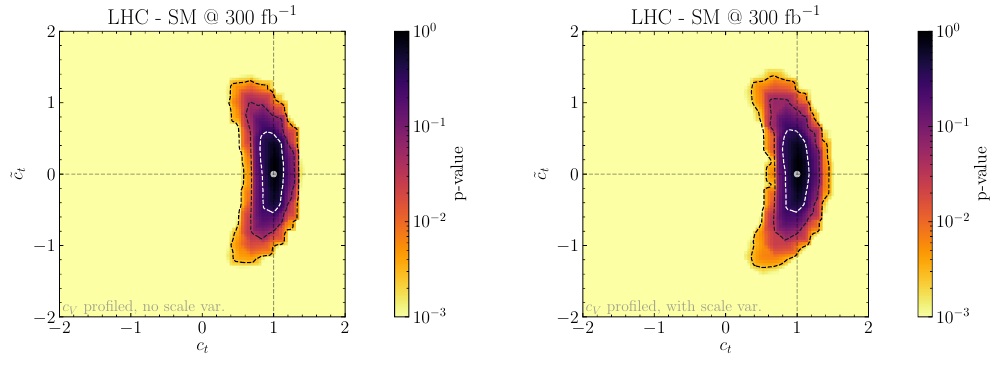
Figure 5 . Left: expected limits on c t and ˜ c t with a luminosity of 300 fb − 1 for a freely floating c V . Right: same as left, but also the renormalization scale is